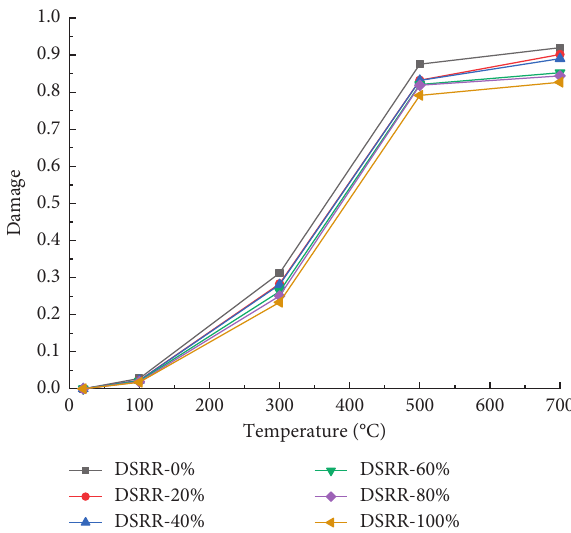
Figure 19: Relation between damage and